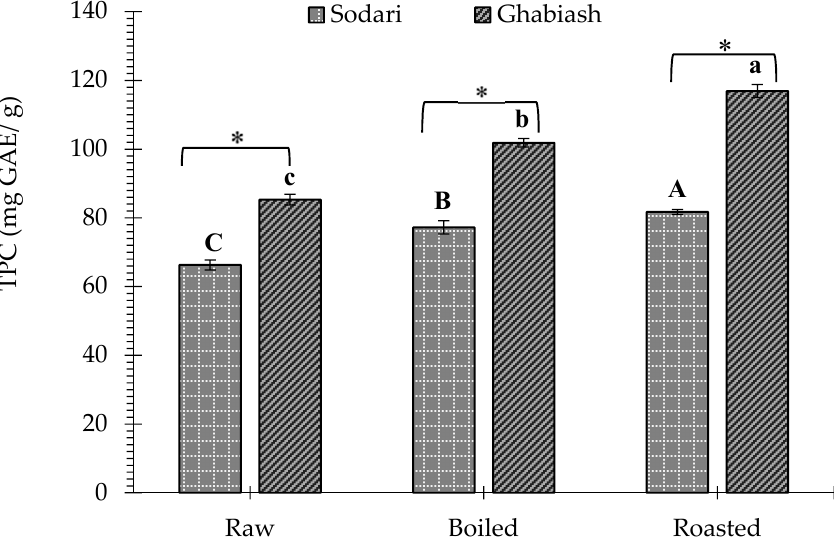
Figure 1. Effects of boiling and roasting on the total phenolic content (TPC) of peanut pod shells of Sodari and Ghabiash cultivars. Data represent mean ± SD ( n = 3). Values followed by the same letter are not significantly different ( p < 0.05) as evaluated by LSD. Capital letters indicate significant differences between raw and processed samples of Sodari cultivars, whereas lower case letters indicate significant differences between raw and processed samples of Ghabiash cultivar. * shows the significant differences between means of cultivars, while ns shows the insignificant differences between means of cultivars in the raw and processed